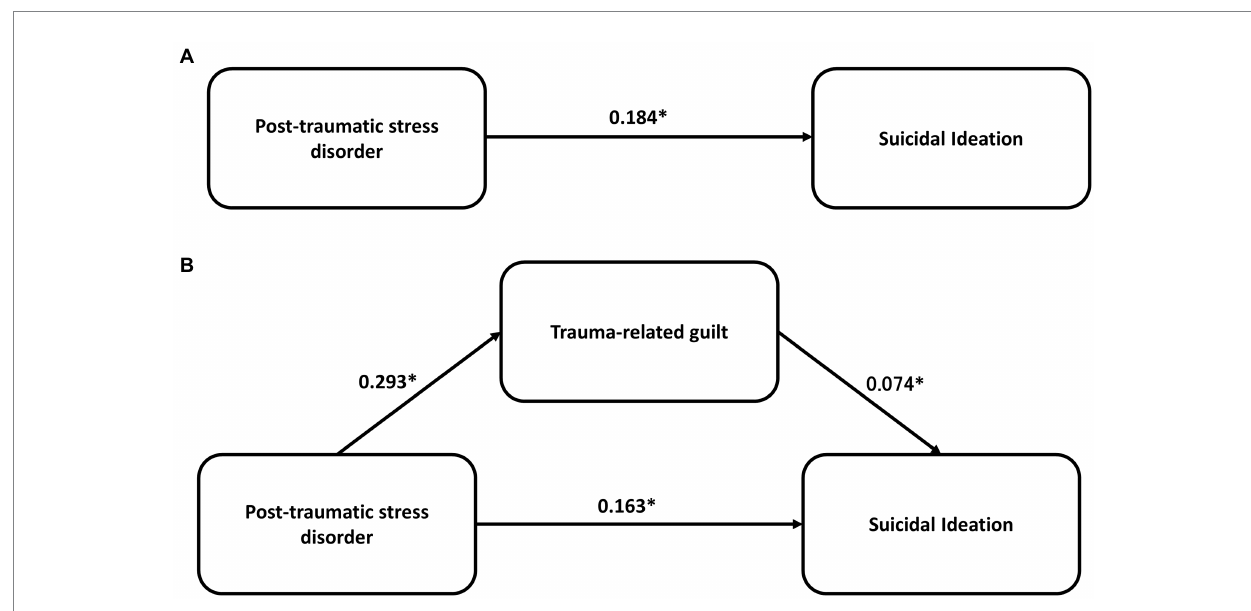
FIGURE 1 The mediation effect of trauma-related guilt on the association between post-traumatic stress disorder and suicidal ideation. * p <